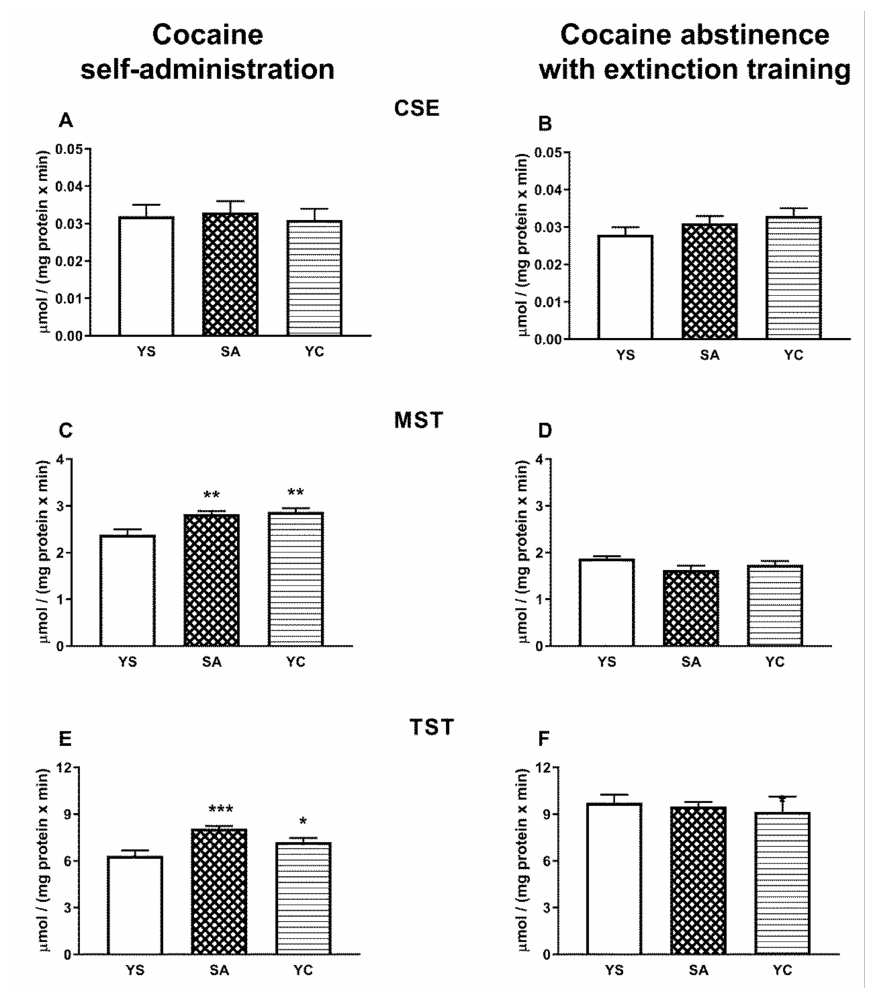
Figure 6. The activity of CSE, MST, and TST in the presence of cocaine ( A , C , E ) and after 10 days of drug abstinence with extinction training ( B , D , F ) in the livers of rats self-administering cocaine (SA), receiving passive cocaine infusions (YC), and receiving saline infusions (YS): data are presented as the mean ± SEM, n = 8–10 per group. * p < 0.05, ** p < 0.01, *** p < 0.001 vs. YS